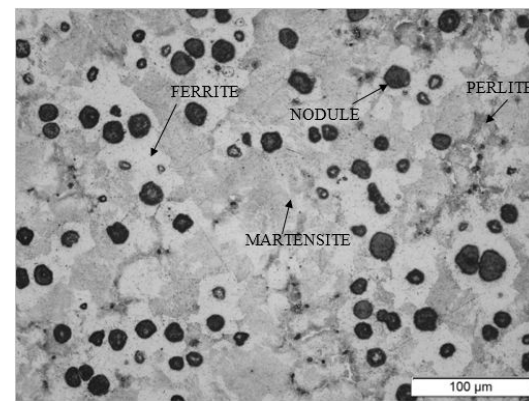
Figure 12. Matrix for Cr addition.